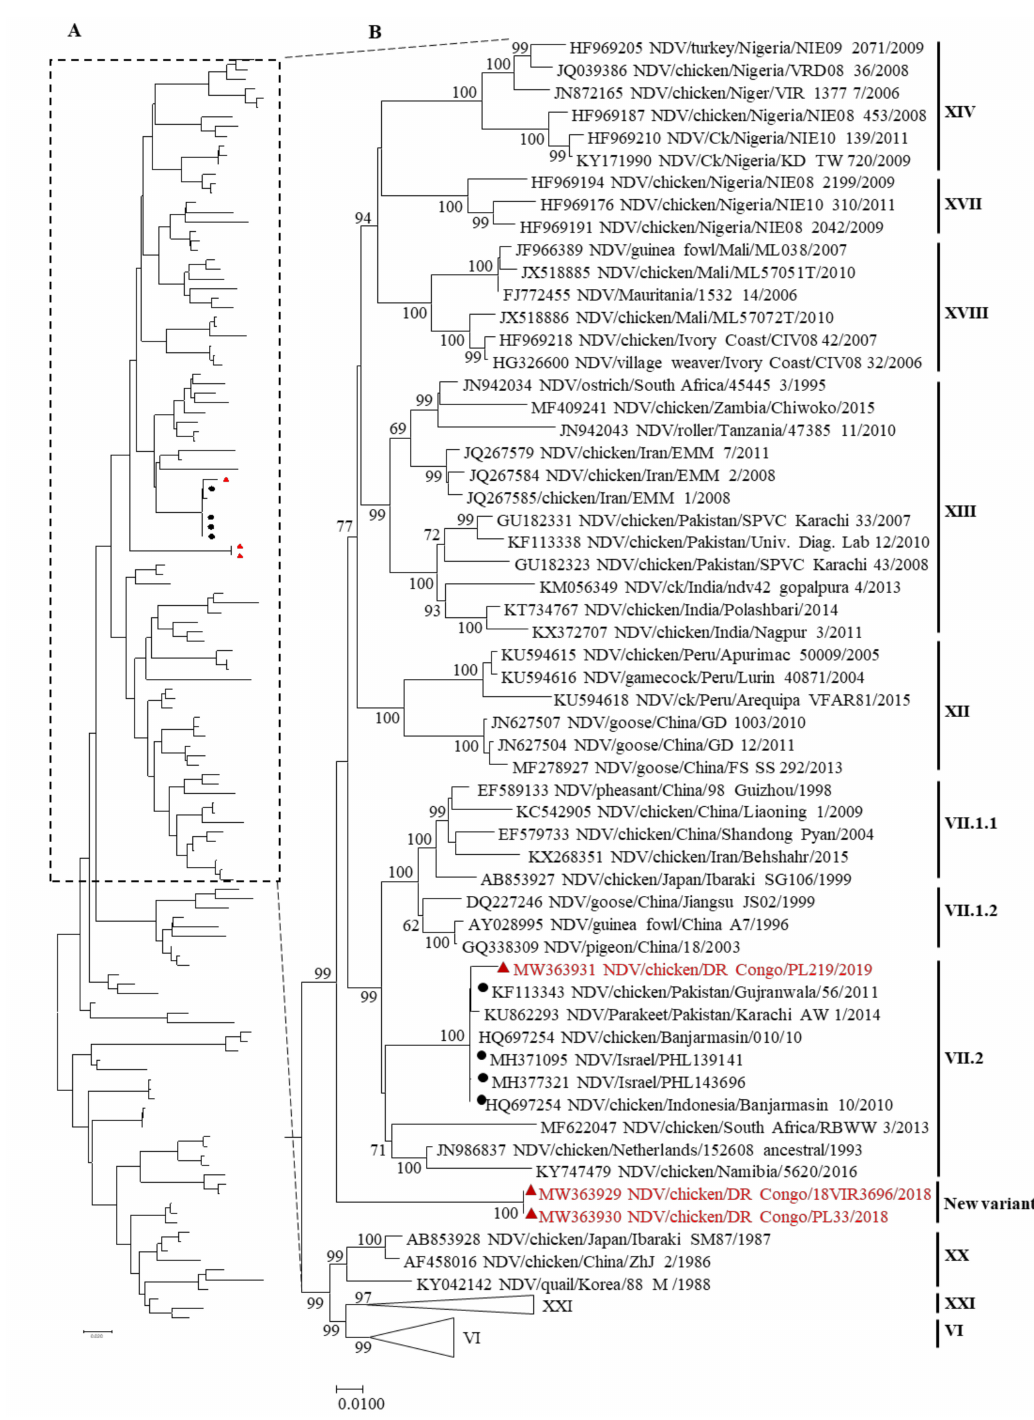
Figure 1. Phylogenetic tree of class II NDV based on the full-length nucleotide sequence of the fusion gene containing 133 sequences including the Congo strains. The analysis was performed in MEGA7 v 7.0.23 using the maximum-likelihood method based on the general time reversible model with 1000 bootstrap replicates. ( A ) The entire phylogenetic tree in which the taxa tips are not shown. ( B ) Part of the tree is shown with all taxa tips indicated; the vertical bar indicates the genotype or subgenotype of each strain group or individual. The triangle and red color indicate the Democratic Republic of the Congo isolates. The black circle indicates the strain in the top five hits of the BLAST search result of the Congo strain NDV/Ck/DR